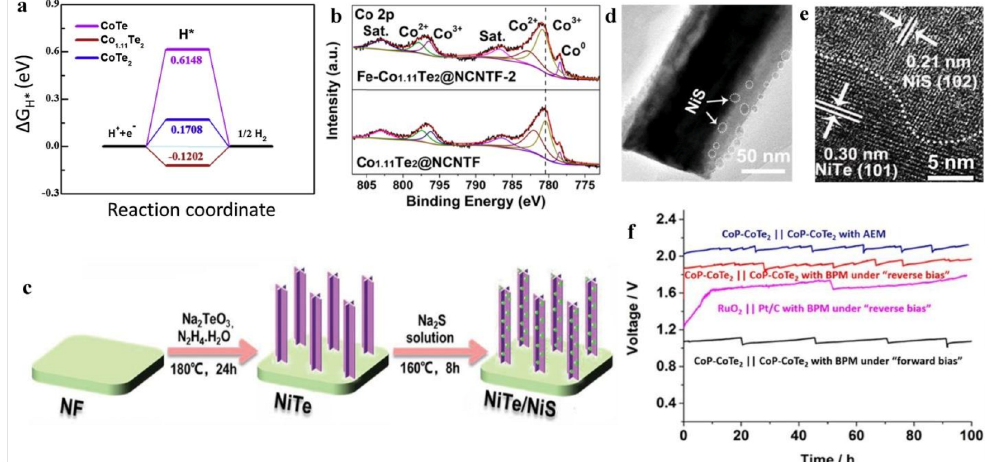
Figure 4. ( a ) Gibbs free energy diagram for CoTe, CoTe 2 and Co 1.11 Te 2 reproduced from [117]; ( b ) XPS spectra images of Fe-Co 1.11 Te 2 @NCNTF and Co 1.11 Te 2 @NCNTF, reproduced from [118]; ( c ) schematic design of the synthesis of NiTe/NiS decorated on heterojunction nanoarrays, reproduced from [119]; ( d , e ); transmission electron microscopy images of NiTe/NiS decorated on heterojunction nanoarrays reproduced from [119]; ( f ) catalytic stability results of BPWEM, reused from